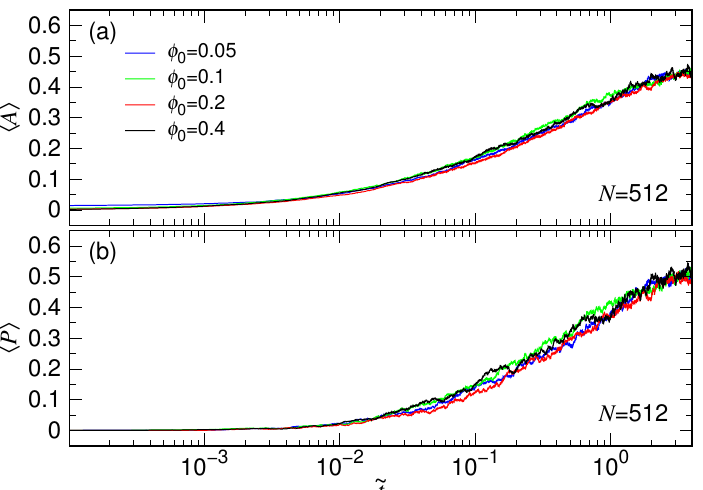
Figure 11. ( a ) Asphericity (cid:104) A (cid:105) and ( b ) prolateness (cid:104) P (cid:105) , plotted against the scaled time ˜ t . The chain has N = 512, expanding from four different initial volume fraction φ 0 . The value of φ 0 can be read in the legend of Panel ( a